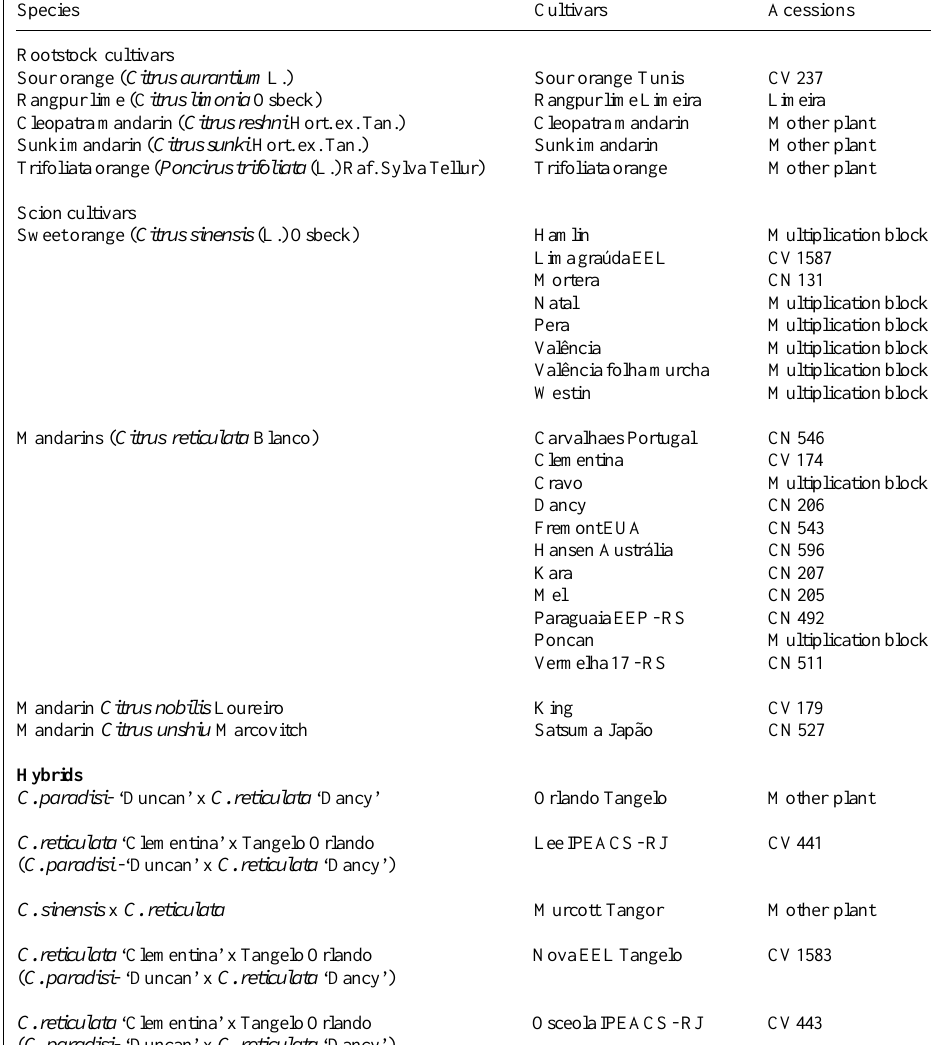
Table I - Citrus species, cultivars and hybrids analyzed (identified according to Tanaka, 1954). Species Rootstock cultivars Sour orange ( Citrus aurantium